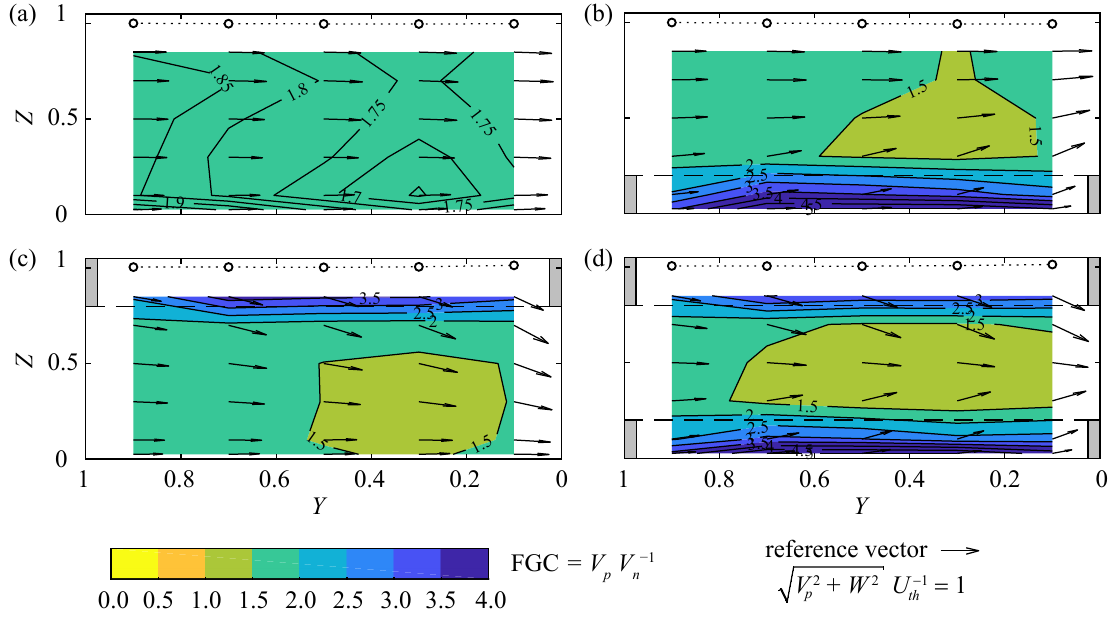
Figure 9. Values of rack-parallel fish guidance capacity (FGC) upstream of the rack S4, α = 30 ◦ , s b = 20 mm for the overlay configurations ( a ) H Bo = H To = 0 ( ξ R = 0.23), ( b ) H Bo = 0.2, H To = 0 ( ξ R = 0.48), ( c ) H Bo = 0, H To = 2 ( ξ R = 0.50), and ( d ) H Bo = H To = 0.2 ( ξ R =